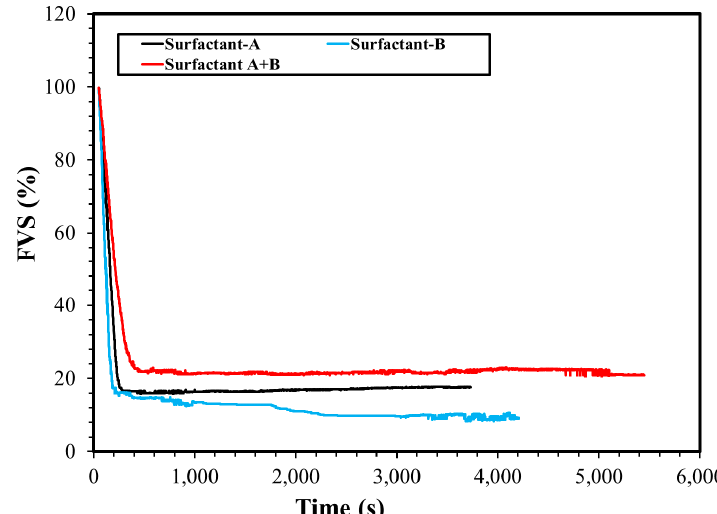
Figure 8. Foam volume stability (FVS) of surfactants using CO 2 injection when dissolved in the SW at 80 °C.